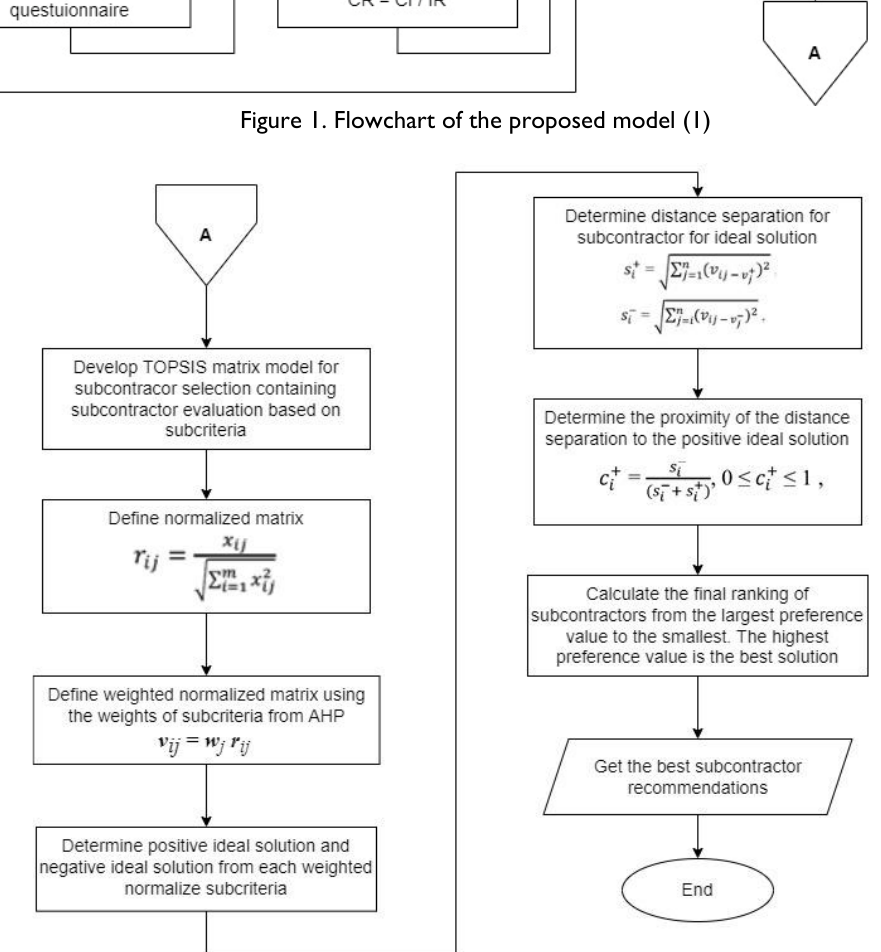
Figure 2. Flowchart of the proposed model